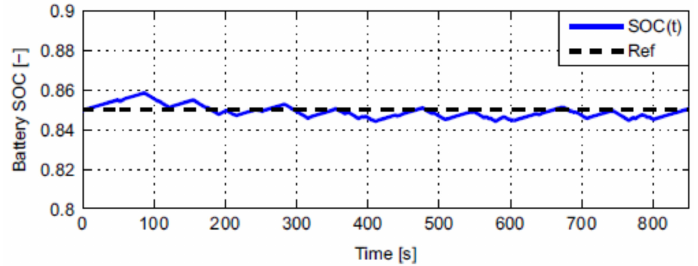
Figure 3. Result for state of charge of the battery using the proposed algorithm [13].